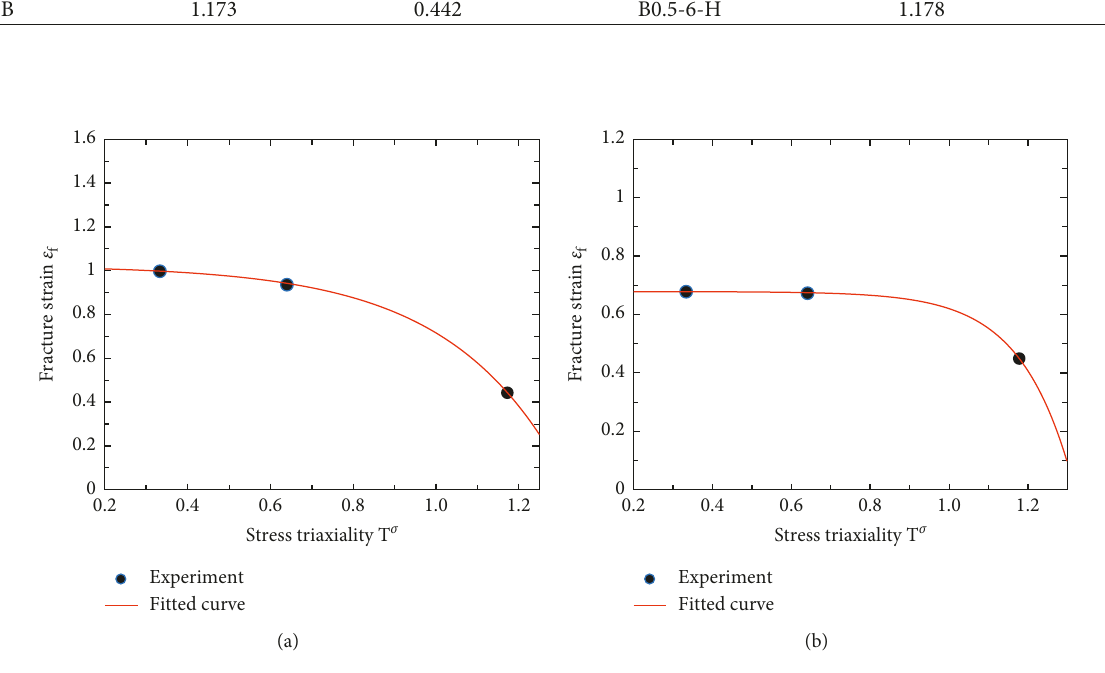
Figure 13: Fracture criterion. (a) BMZ. (b) HAZ.